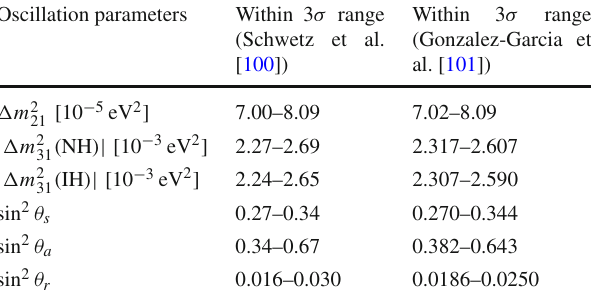
Table 2 Neutrino oscillation parameters in 3 σ range Oscillation parameters Within 3 σ